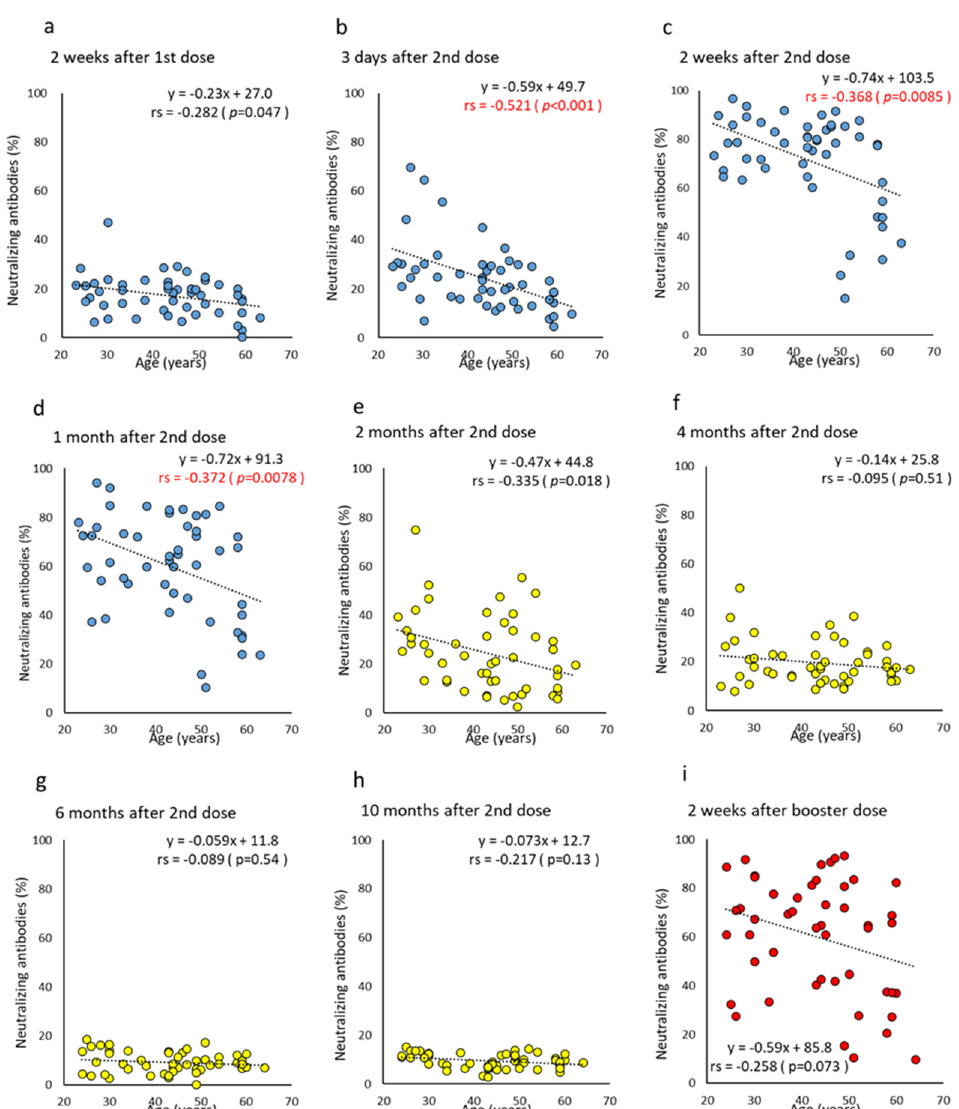
Figure 4. ( a – i ). Correlation at time points between age and neutralizing antibodies after BNT162b2 vaccine doses. Parameter levels indicating neutralizing antibodies of humoral immunity against SARS-CoV-2 are plotted and compared according to age at each time point post-vaccine doses. Time points until one month after two doses are colored blue ( a – d ), from two months to 10 months after two doses are colored yellow ( e – h ), and two weeks after the booster dose are colored red ( i ). p -values were calculated using Spearman’s rank correlation test and significance was set at 0.01. Red values indicate a significant correlation (rs, Spearman’s rank correlation